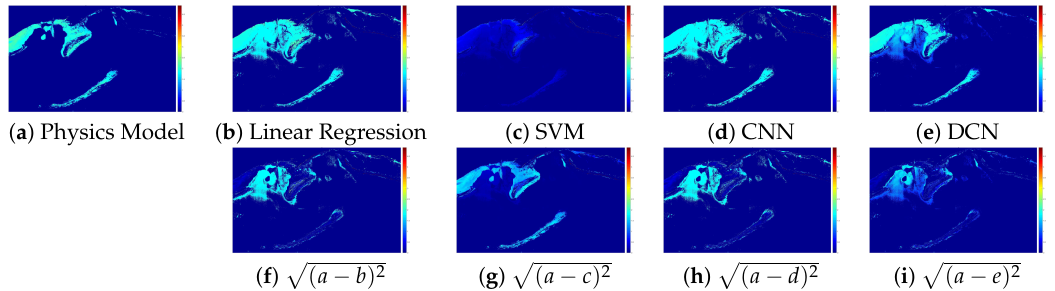
Figure 7. LAI mapping at Saint George Sound produced by models trained with patches from the selected regions. The LAI maps are masked to show only those pixels that are classified as seagrass by the capsule network.